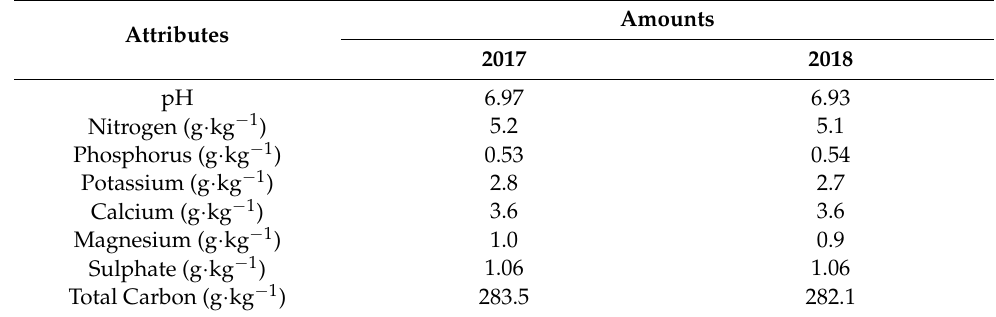
Table 2. Chemical characteristics of municipal solid